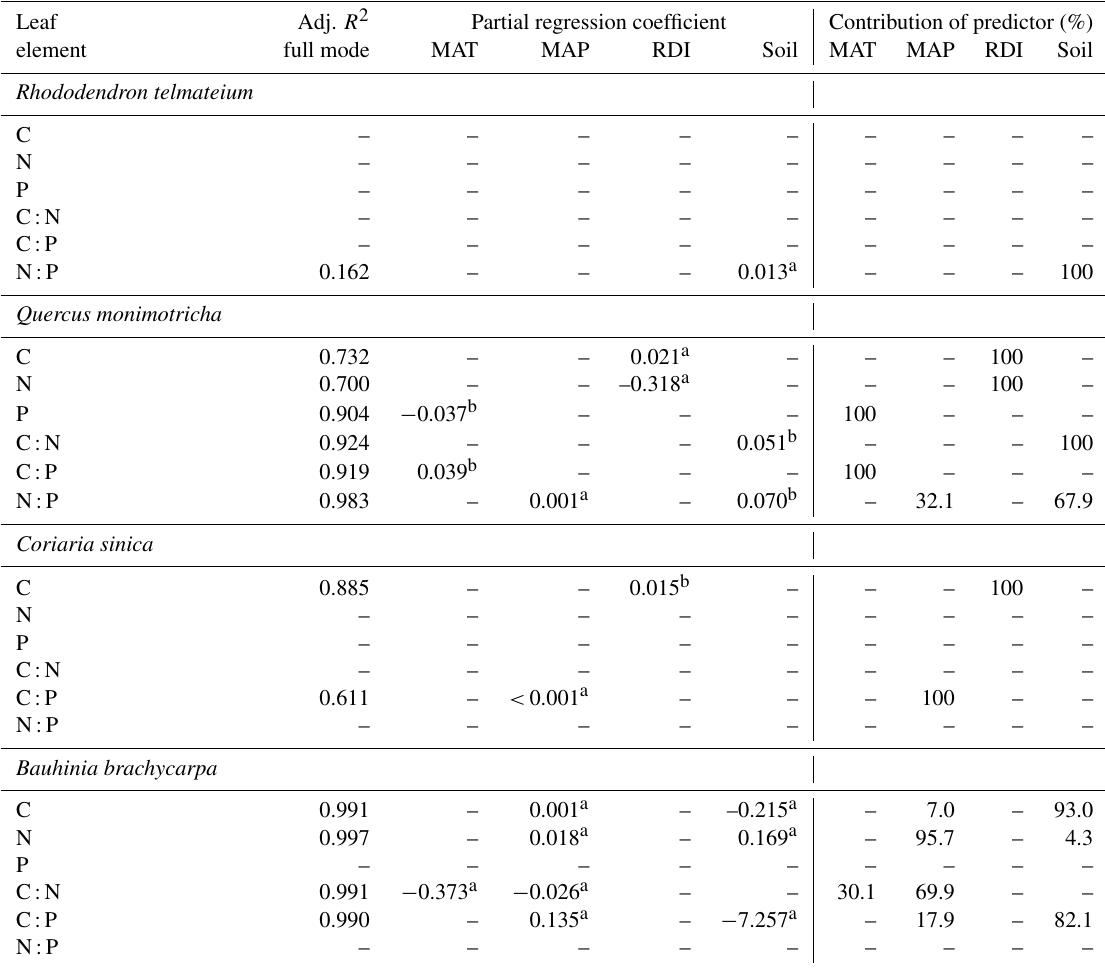
Table A6. Model summary for the stepwise multiple regression (SMR) of leaf element concentrations of dominant shrub species on the climatic and soil variables (MAT, MAP, RDI, soil element and ratio). Leaf Adj. R 2 Partial regression coefficient Contribution of predictor (%) element full mode MAT MAP RDI Soil MAP RDI Soil